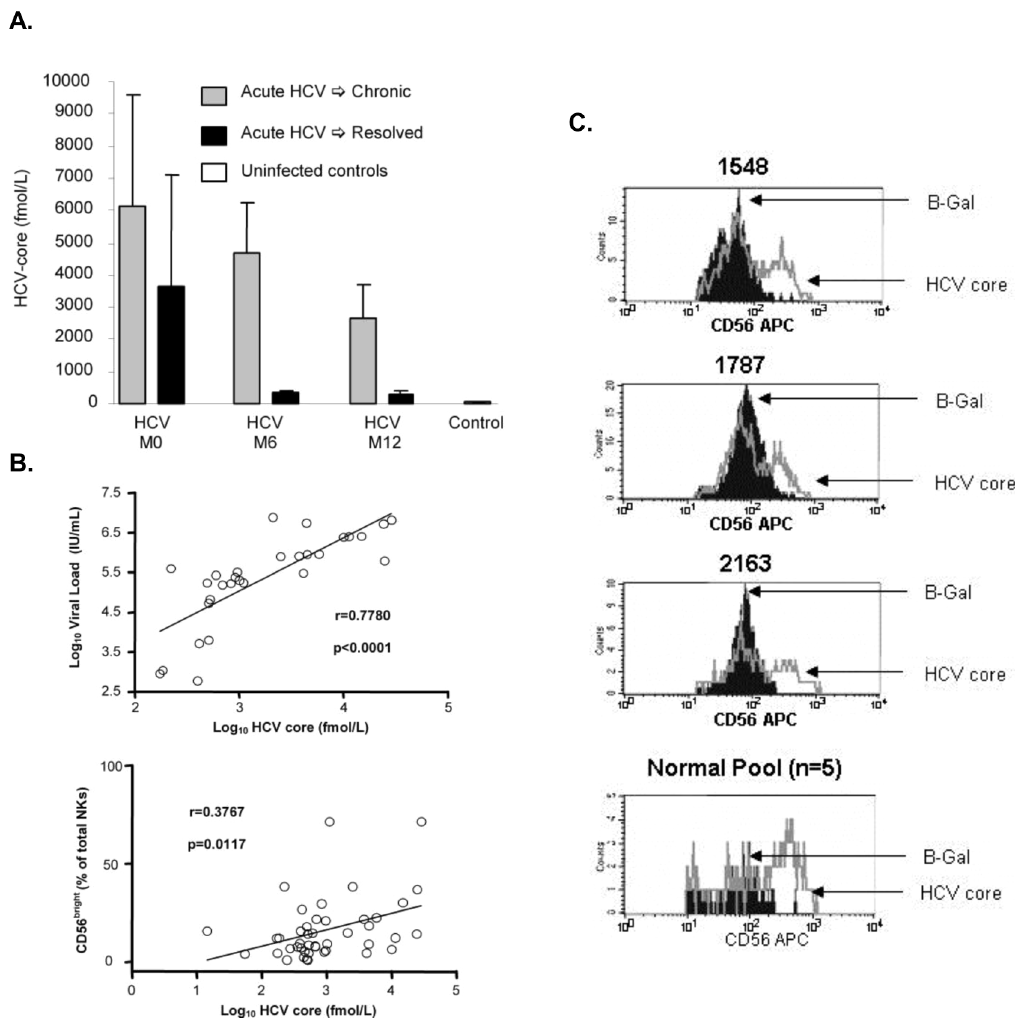
Figure 4. Circulating HCV-core levels in acute HCV infection and effect of extracellular core on NK cell CD56 expression. Circulating HCV-core protein levels as measured by ELISA (A) . As expected, core levels correlated directly with viral levels in HCV-infected patients. There was also a direct statistically significant correlation between core and the levels of CD56 bright NK cells in these patients. Multiple time points were used for chronic patients (B) . Incubation of highly purified FACS sorted CD56 bright NK cells, from normal uninfected control subjects, in the presence of HCV- core or beta-galactosidase ( b -Gal) control protein demonstrated inhibition of CD56 down-regulation by exogenous HCV-core protein. Histograms of CD56 expression levels after incubation are shown for four individual experiments (C) . The first three histograms represent individual normal control subjects and the fourth histogram is derived from an experiment in which PBMCs from five normal uninfected control subjects were pooled prior to sorting on CD56 bright NK cells and incubation with